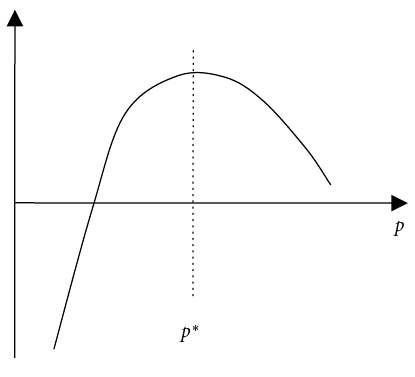
Figure 6: The net profit